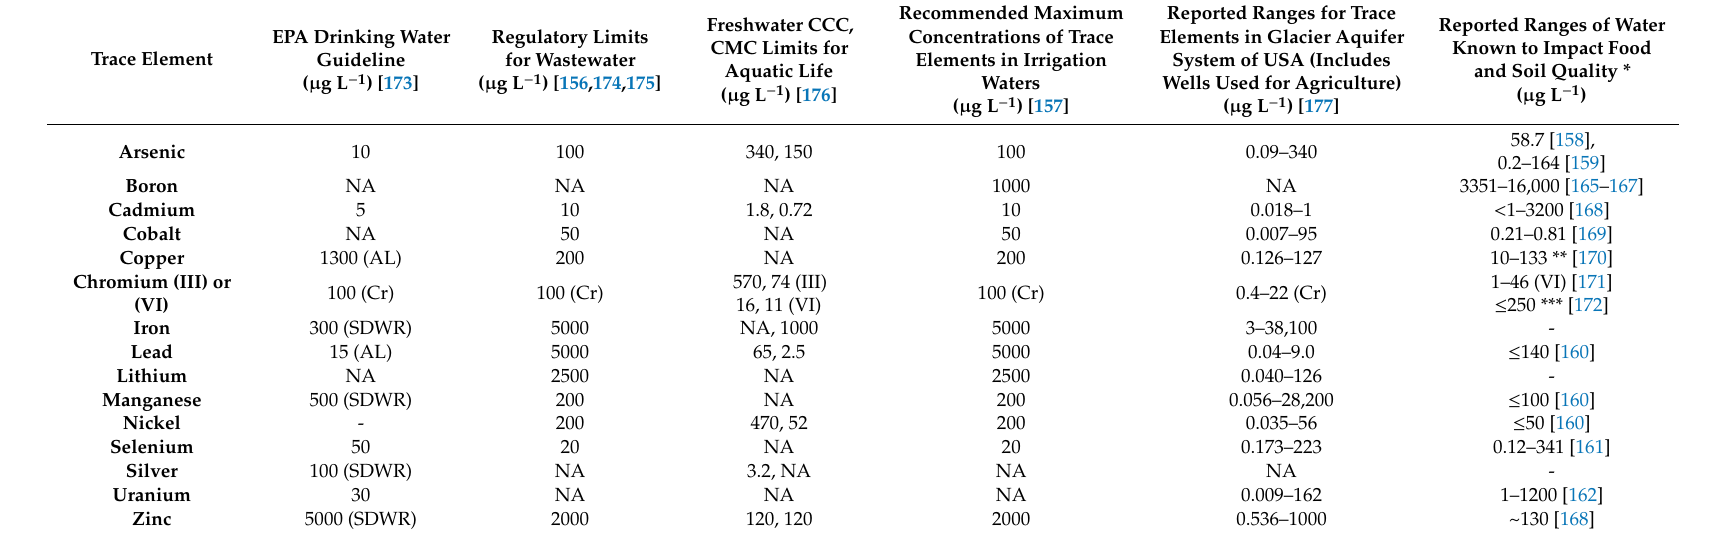
Table 1. Common geogenic trace element contaminants in irrigation water with current regulatory and recommended levels (NA: Not Available, AL: Action level, CCC: Criterion continuous concentration, CMC: Criterion maximum concentration, SDWR: Secondary drinking water regulations). (* Few examples of plant uptake, ** in µ g, *** greenhouse experiment concentration was equivalent to natural